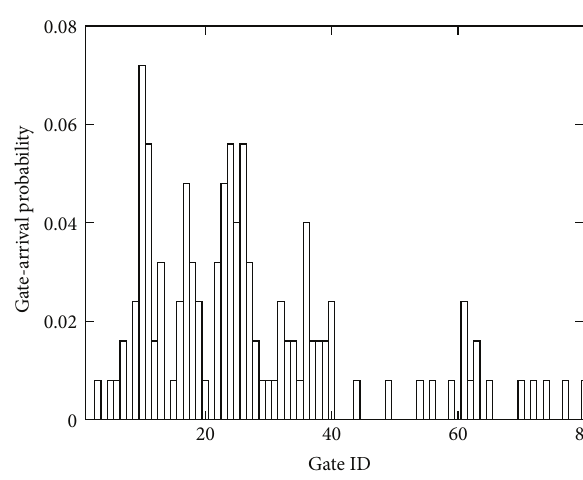
Figure 8: Distribution of gate arrival probabilities P